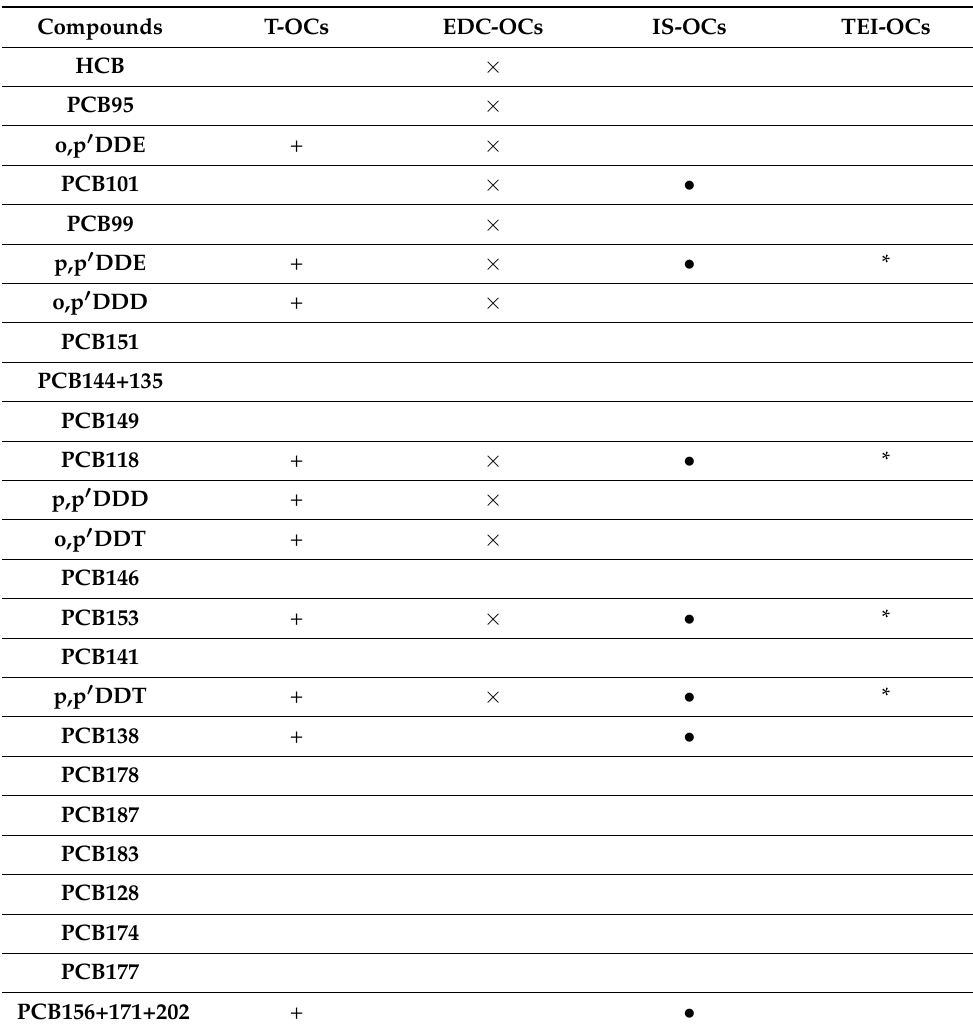
Table 2. Analyzed compounds with their toxicological characteristics: cancerogenic, mutagenic, and teratogenic organochlorine compounds (T-OCs), Endocrine Disrupting Chemicals (EDC-OCs), immunosuppressant organochlorine compounds (IS-OCs), and the OCs showing qualities of both T-OCs and EDC-OCs as well as IS-OCs (TEI-OCs) [67–87]. The symbols: +, × , • , * represent the indicators of contaminants belonging to the respective group. Compounds T-OCs